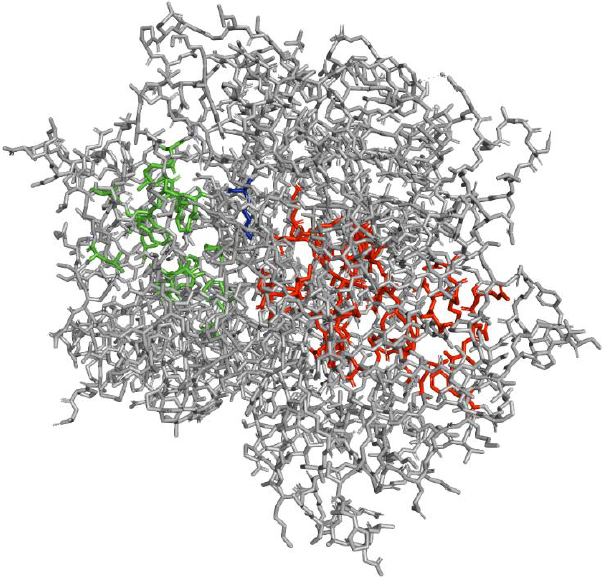
Figure 9. 5WGR-crystal structure of wild-type MalA’, premalbrancheamide complex: separation between substrate binding pocket (green), FAD binding pocket (red), and lysine 108 (blue) [30].